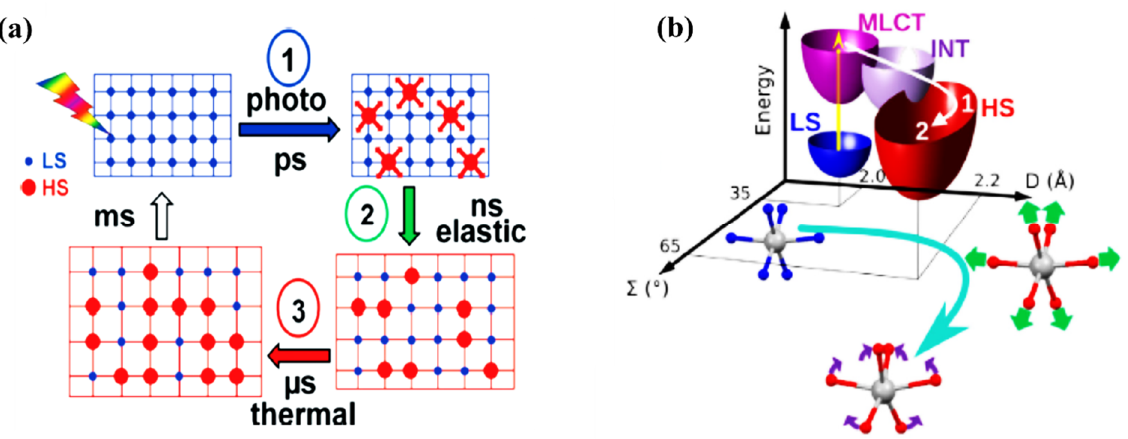
Figure 6. ( a ) A schematic drawing of the multiprocess switching dynamics of solid SCO materials [51]. ( b ) The schematic representation of the pathway from low spin to high spin [Fe(phen) 2 (NCS) 2 ] crystal with the 2D vibronic states (D—elongation and Σ —bending) is indicated. The fast intersystem crossing (1), through intermediate states, drives the Fe-N elongation (2) with the generation and damping of the breathing mode followed by the activation bending mode (3). Reprinted with permission from Ref. [51] and Ref. [63]. Copyright 2009 and 2014 by the American Physical Society. The change in the intramolecular bond length of monoclinic [(TPA)Fe(TCC)]PF 6 appears to accompany the change in the HS molecular fraction, with respect to time, in the initial step of the LS to HS state switching process, as shown in Figure 7a [51]. The one molecule. The HS fraction change is about 3%, and the change in bond distance ∆ <Fe-N> ≈ 0:005 Å due to photo transformation in the first 100 ps, for the experimental conditions as shown in Figure 7a. These changes become larger at around the 100 µ s time scale, at which the high spin fraction reaches around 6% and the change in bond distance ∆ <Fe-N> reaches 0.01 Å